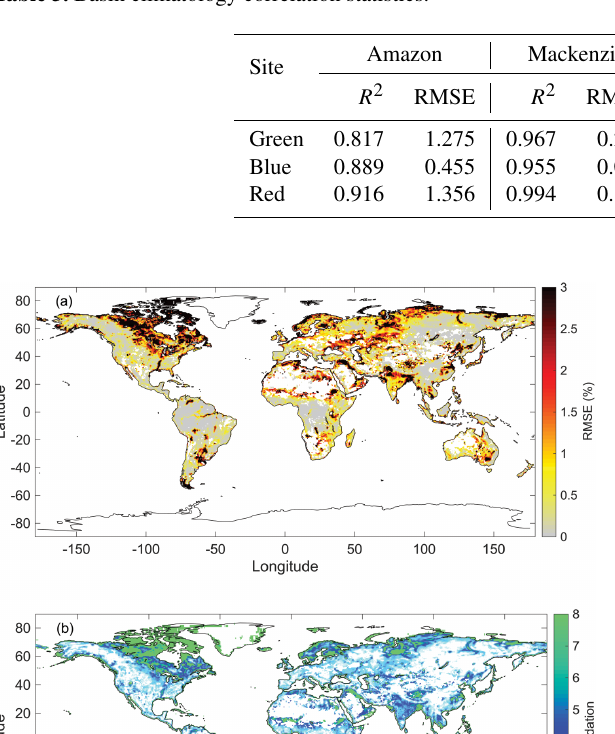
Table 3. Basin climatology correlation statistics.